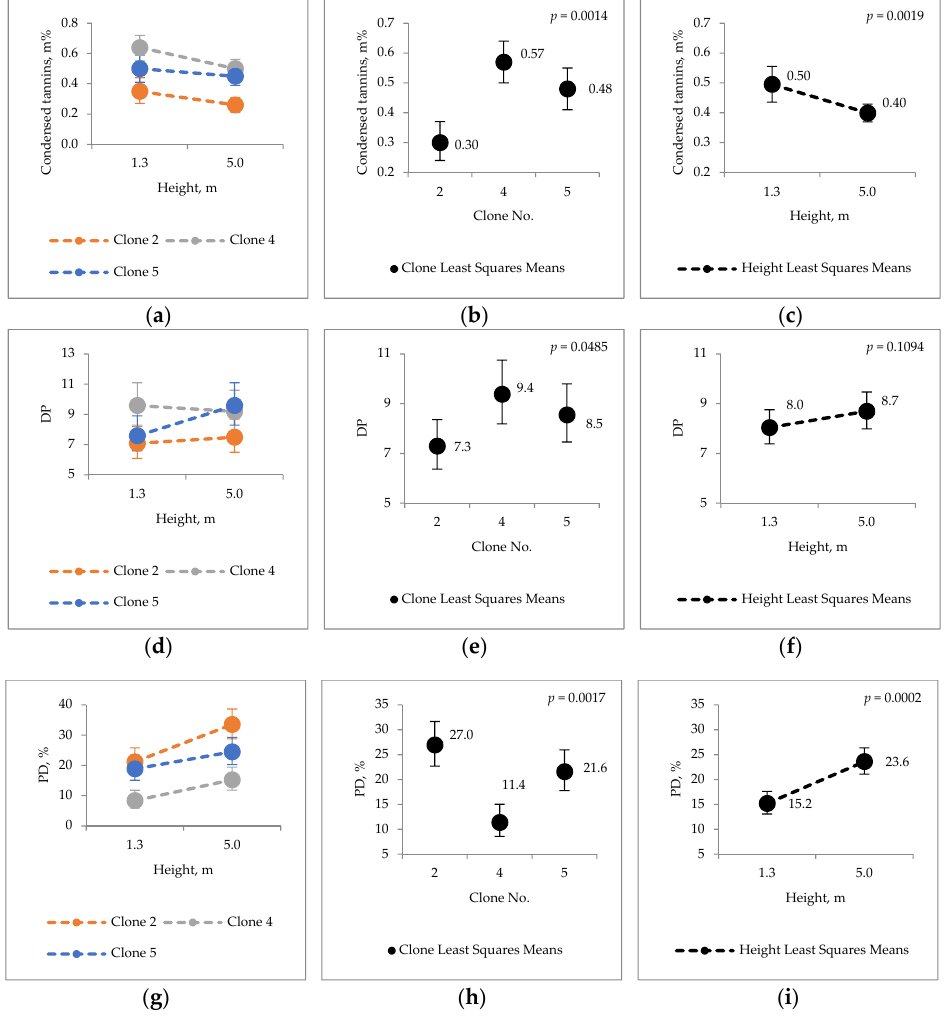
Figure 3. Hybrid aspen clone bark; ( a – c ) condensed tannins (CT) contents ( d – f ) average degree of polymerization (DP) for total flavan-3-ols and percentage value of prodelphinidins (PD, %), i.e., (epi)gallocatechin subunits in condensed tannins ( g – i ).